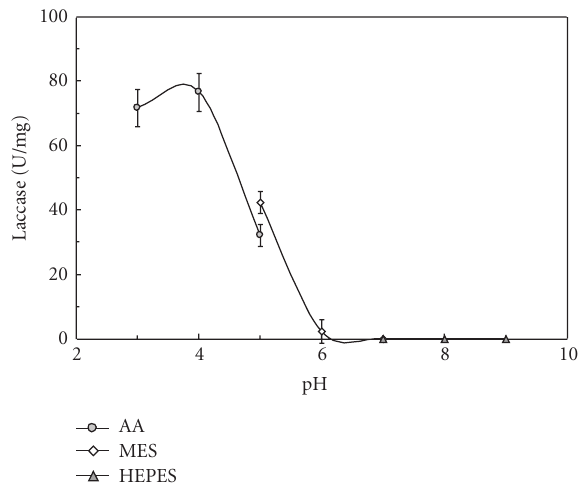
Figure 4: E ff ect of pH on activity of Lentinus tigrinus laccase.